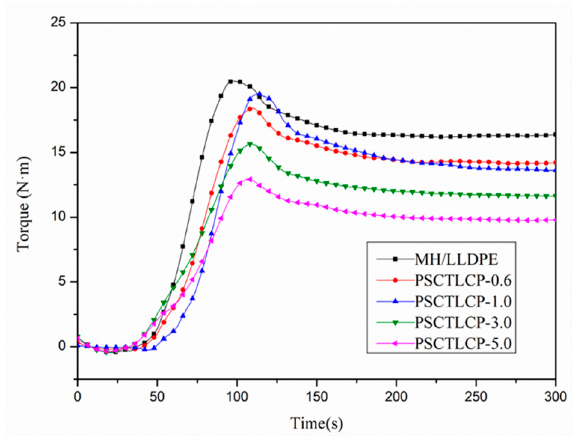
Figure 5. Torque versus time of MH / LLDPE / PSCTLCP composites with various PSCTLCP loading.